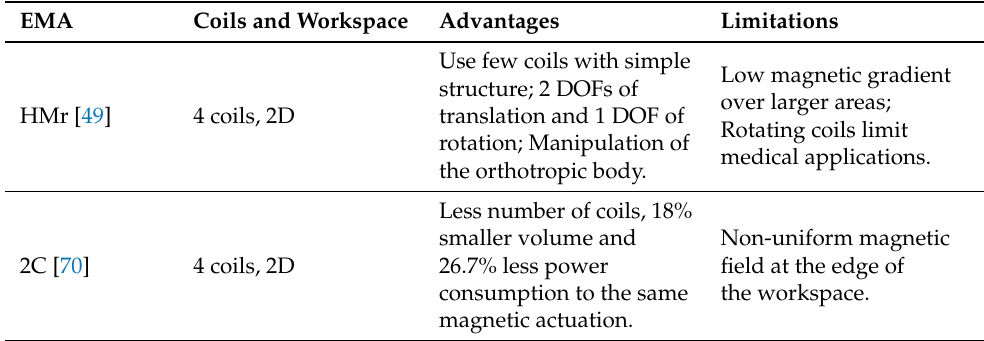
Table 2. Comparisons of the EMA